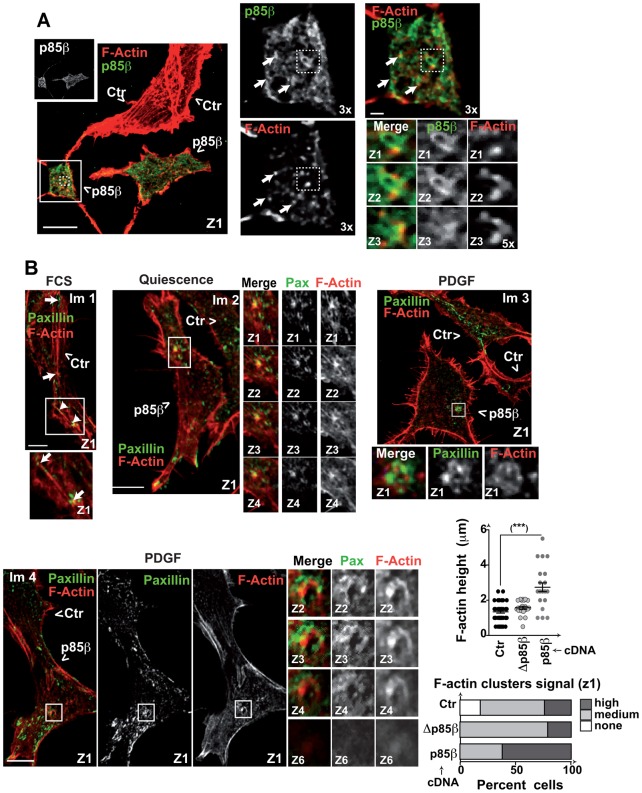
p85β expression induces formation of F-actin-positive adhesions.(A) NIH3T3 cells transfected with CFP combined with control or HA-p85β cDNA (48 h) were evaluated by immunofluorescence using anti-HA Ab and phalloidin-TRITC. Representative images of the first confocal section (z1). Insets show 3× magnification of indicated areas, small insets show 5× magnification of serial z-sections, arrows indicate areas of phalloidin and HA proximal staining. Transfected cells were tracked with CFP. (B) NIH3T3 cells were transfected with CFP combined with control HA-p85α, -p85β or -Δp85β cDNA (48 h). Cells were tested after incubation in serum-free medium (2 h), after activation with PDGF (50 ng/ml; 10 min) or in exponential growth (with serum). Cells were stained with phalloidin-TRITC and paxillin. The graphs show the percentage of paxillin+ clusters/rosettes with F-actin signals scored as high (similar to that of cortical F-actin), medium (lower than cortical F-actin signal), or none, and height of F actin+ clusters (µm) in different cells. Bar  =  12 µm. Step size, 0.5 µm. ***-P-<0.001; Student's t-test.